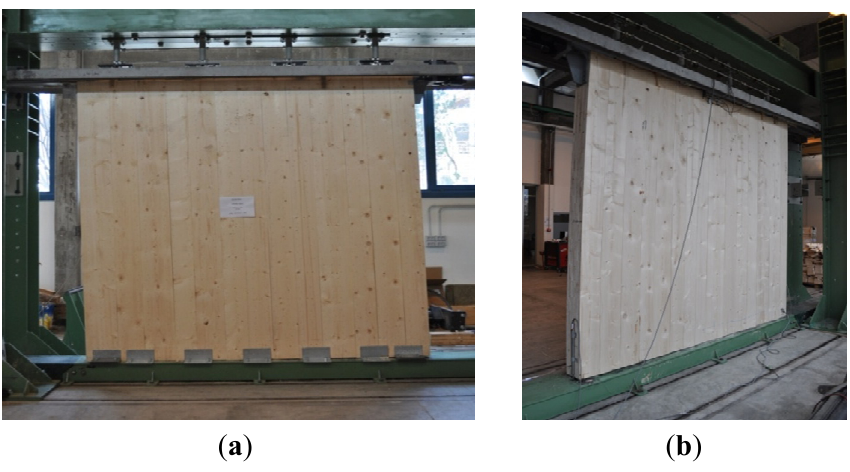
Figure 11. Wall B: Shear deformation of panel at end of testing: ( a ) Front face; ( b ) Rear face.